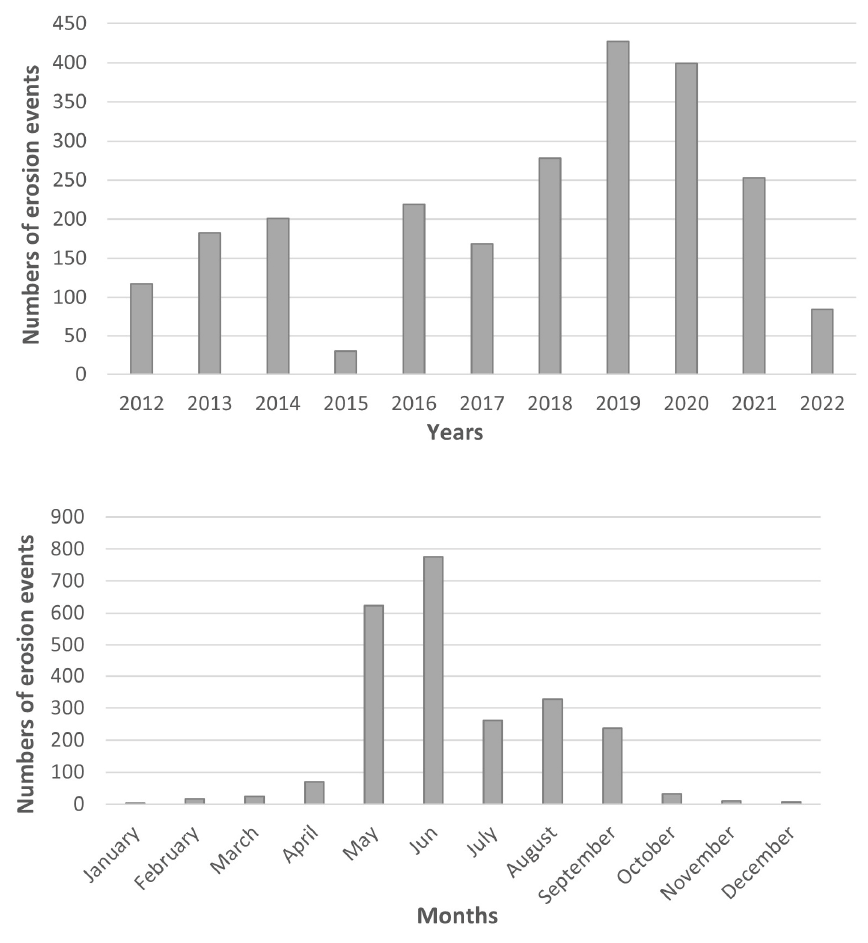
Figure 4. Cumulative numbers of erosion events by the years and months.